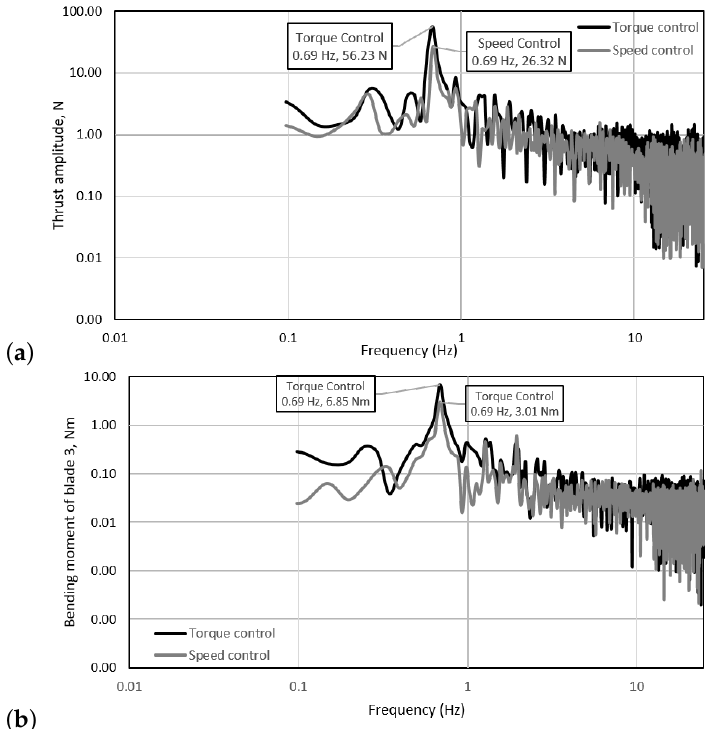
Figure 16. Frequency domain graphs for a regular wave-tow test at peak power condition of TSR = 3.6, i.e., 76 rpm, 15 Nm for: ( a ) thrust and ( b ) root bending moment blade